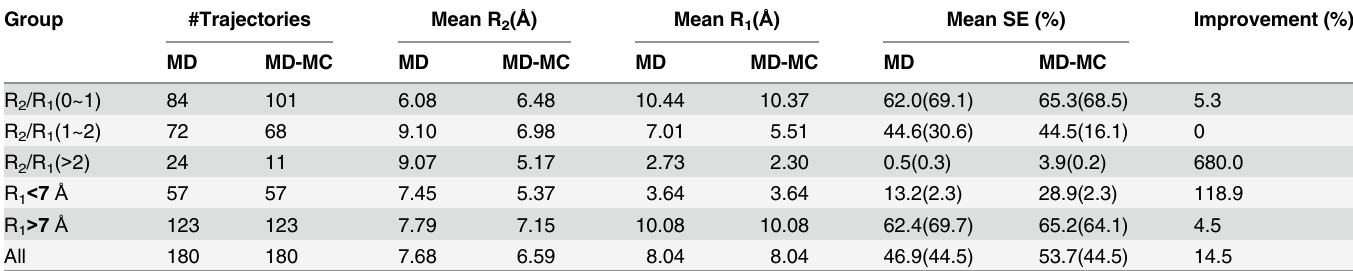
Table 2. Sampling efficiency as a function of R 2 /R 1 and R 1 . The number of trajectories, the mean of R 2 , R 1 and SE are calculated based on 180 trajecto- ries in the backward MD and MD-MC simulations at 370K. Here, R 2 is the sampling range in simulations, R 1 is RMSD between the initial structure and the tar- get structure, SE is the sampling efficiency of a simulation trajectory and the calculated values by Reva ’ s model are listed in following